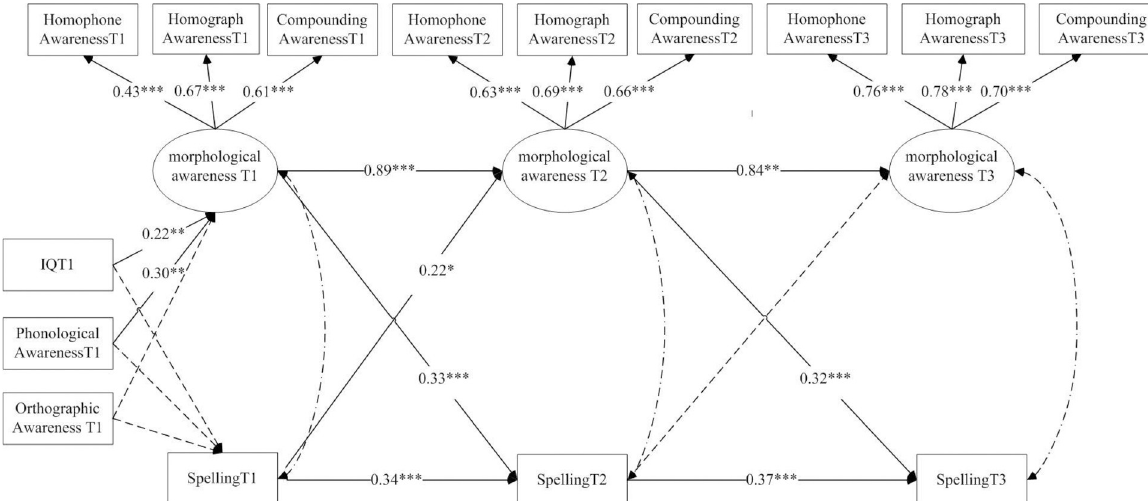
Fig 1. Model of the reciprocal relationship between morphological awareness and